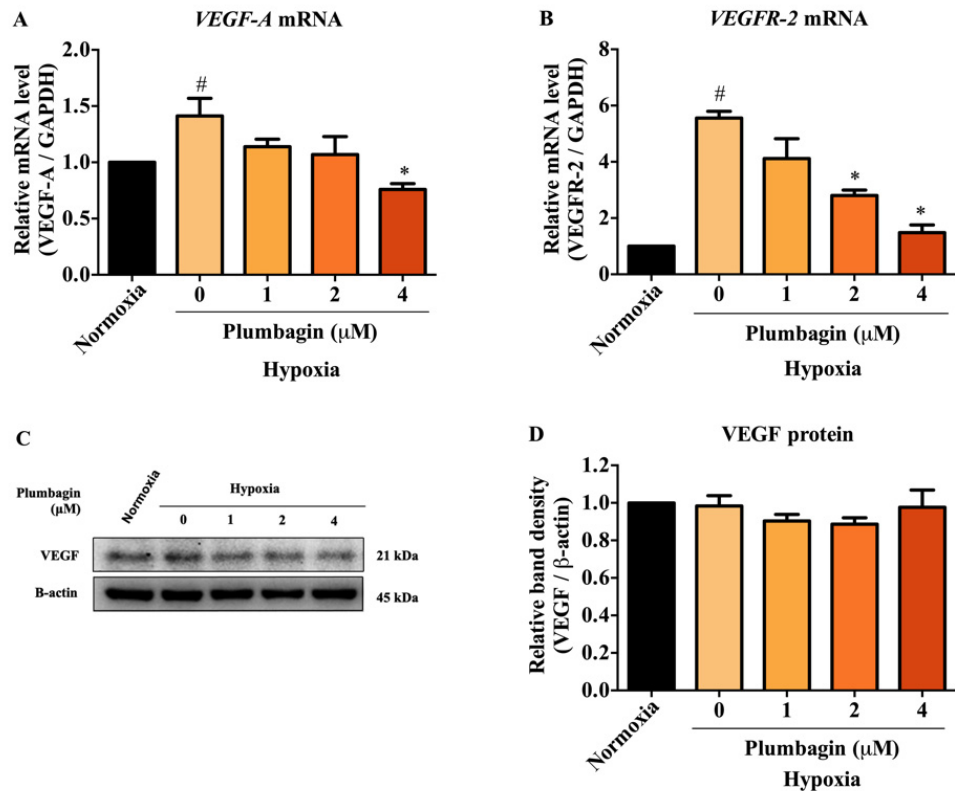
Figure 5. Plumbagin abolished mRNA and protein expression of HIF-1 α target genes under hypoxia. ( A , B ) The mRNA expression of VEGF-A and VEGFR-2 was determined by qRT-PCR. MCF-7 cells were treated with 1, 2, and 4 µ M of plumbagin for 24 h under hypoxic conditions. The relative mRNA expression was quantified and normalized with GAPDH. Data are means ± SEM from three independent experiments ( n = 3). # p < 0.05 vs. normoxic, * p < 0.05 vs. mimic hypoxic group without treatment. ( C , D ) The VEGF protein expression was investigated by Western blotting. MCF-7 cells were treated with 0, 1, 2, and 4 µ M of plumbagin for 24 h under hypoxic conditions. The relative quantities of VEGF protein were quantified and normalized with β -actin. Data are means ± SEM from three independent experiments ( n = 3). 2.5. Suppression of HIF-1 α by Plumbagin Was Not Regulated by the PI3K/Akt/mTOR Pathway The PI3K/Akt/mTOR signaling pathway is associated with the regulation of HIF-1 α protein synthesis. To further examine the mechanism underlying HIF-1 α inhibition by plumbagin, the PI3K, Akt, mTOR, and its phosphorylated forms were detected by Western blotting. BKM120 (PI3K inhibitor), MK2206 (Akt inhibitor), and rapamycin (mTOR in- hibitor) were used as positive controls. Under CoCl 2 -induced hypoxia, the results show that rapamycin inhibited HIF-1 α protein expression, similar to plumbagin compared with the mimic hypoxic group without treatment (Figure 6A,B). However, plumbagin did not affect PI3K, Akt, or mTOR in both phosphorylated forms and total protein levels (Figure 6C–H). The findings suggest PI3K/Akt-independent signaling pathways controlling the effect of plumbagin under CoCl 2 -induced